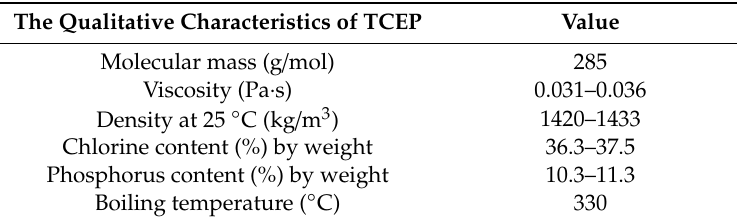
Table 3. Properties of TCEP.